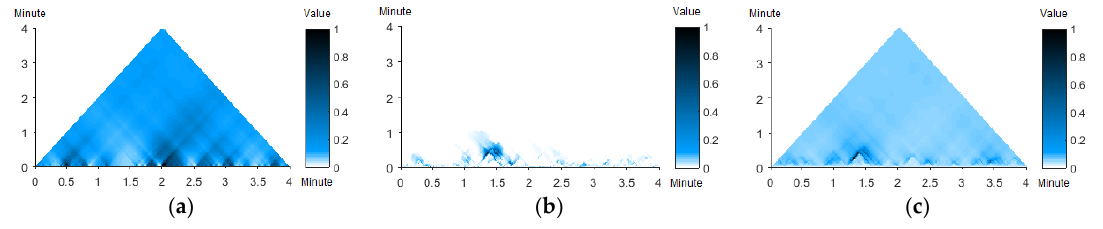
Figure 10. The visualization of the centrality measures of player 6 for the attraction pattern: ( a ) degree; ( b ) betweenness, and ( c ) closeness.